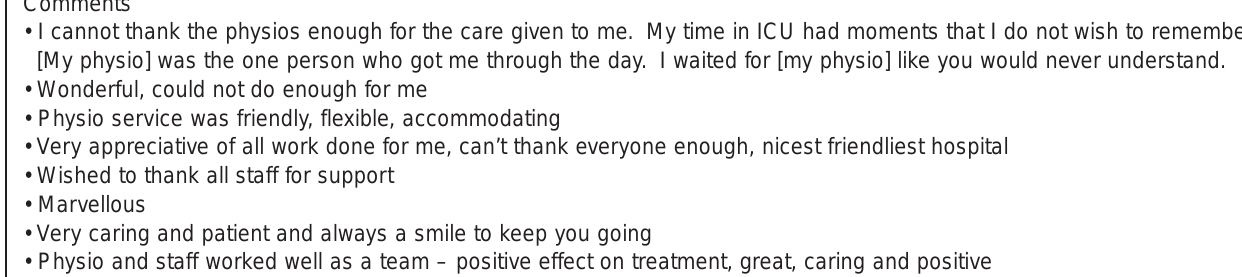
Table 3: Patients’ comments regarding their stay in